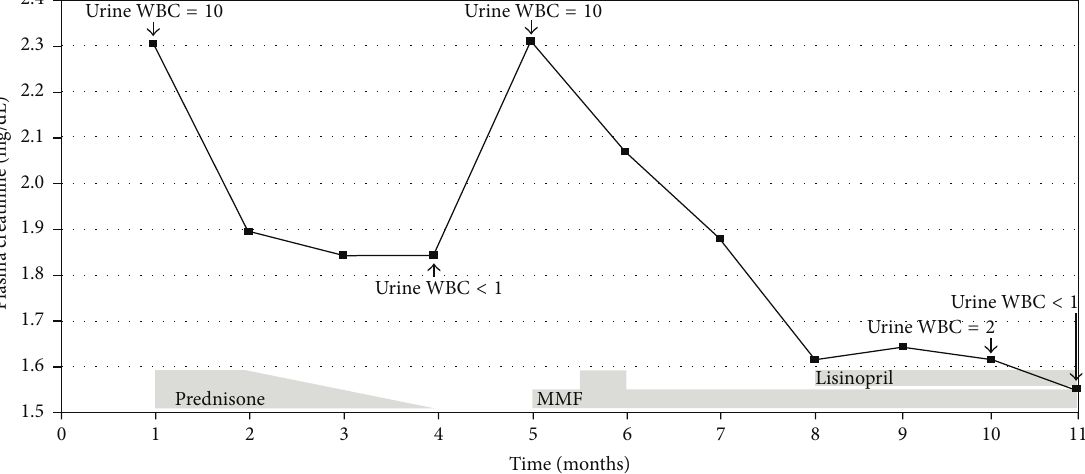
Figure 2: Changes in renal function over time. MMF: mycophenolate mofetil; WBC: white blood cells per high power field on microscopic examination of urine